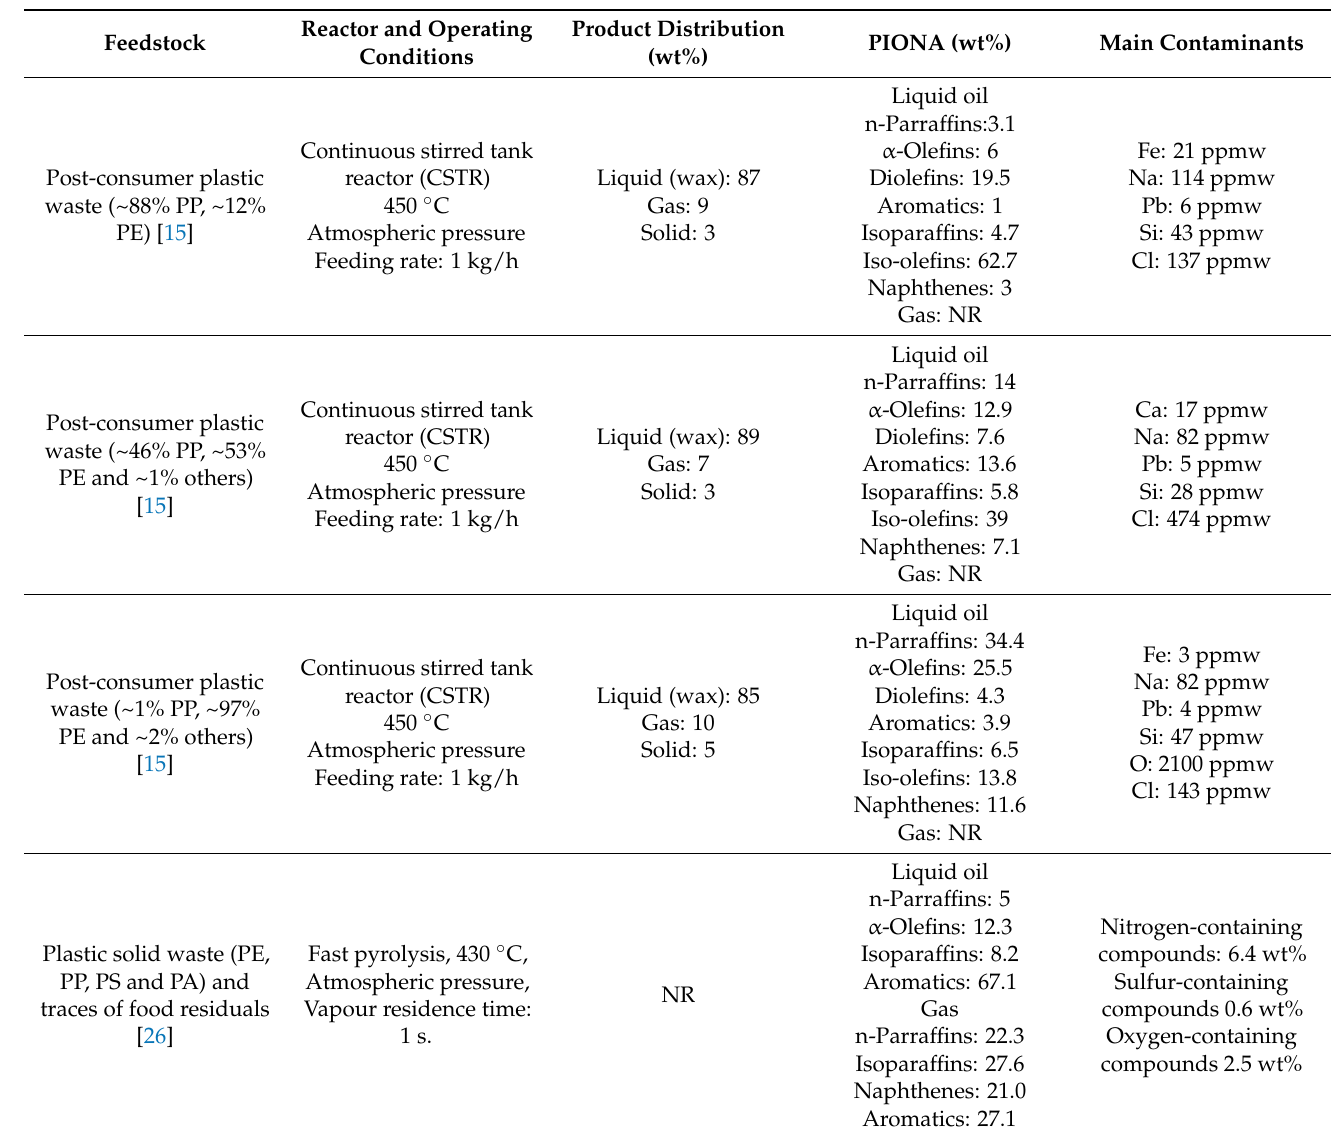
Table 2. Effect of plastic waste composition on the oil quality and the contaminants present in the